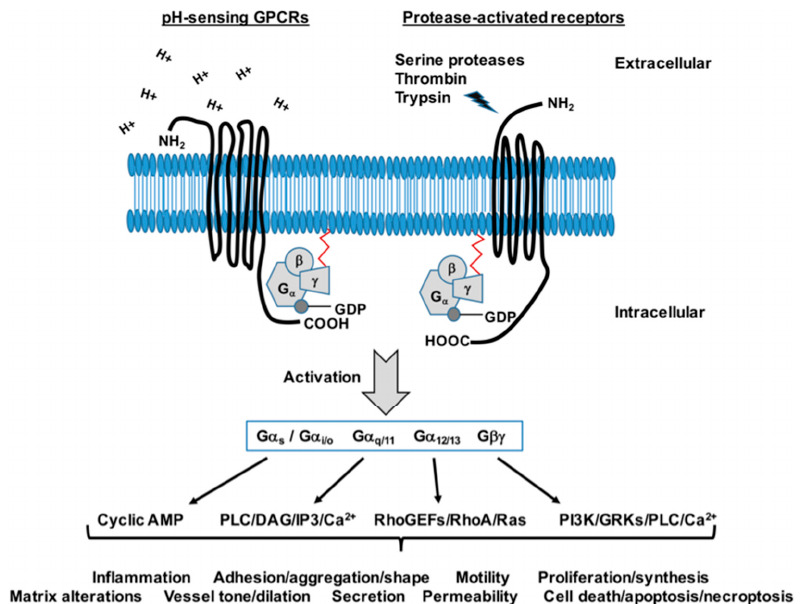
Figure 6. Generalized G protein-coupled receptors: pH-sensing and protease-activated receptors. A